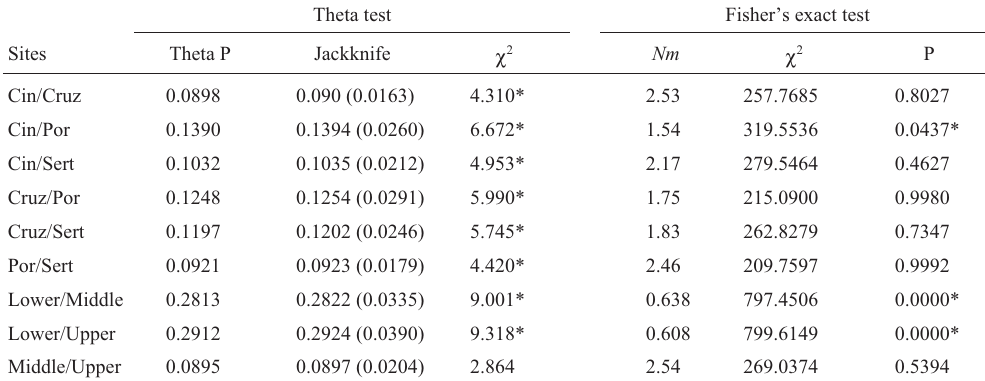
Table 2 - Theta P test, mean number of migrants per generation ( Nm ) and Fisher’s exact test between pairs of A. altiparanae samples from 4 sites at the Capivara Dam and samples from sites in the lower, middle and upper Paranapanema River.